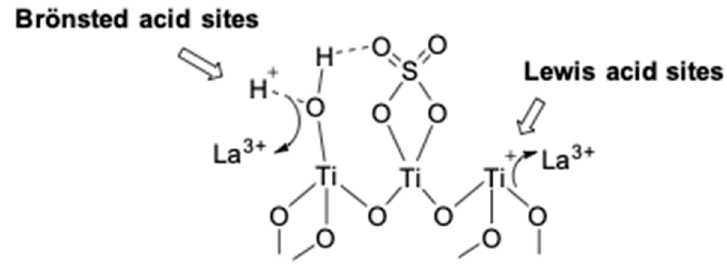
Figure 9. The framework structure of SO 42 − /TiO 2 /La 3+ catalyst.